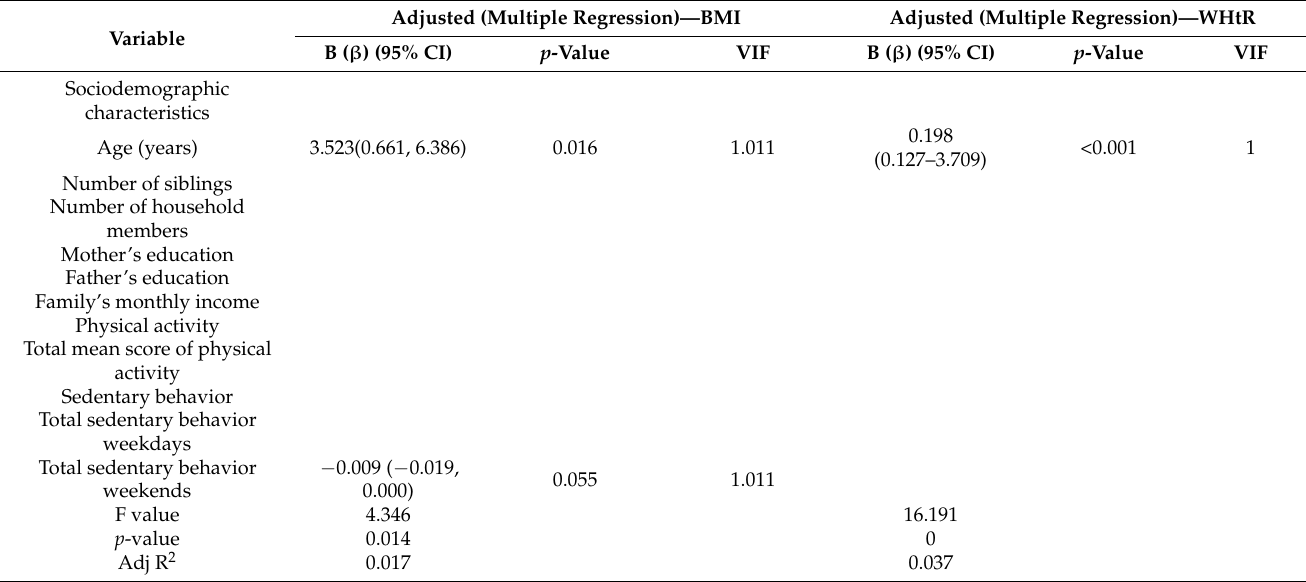
Table 5. Relationship between sociodemographic characteristics, physical activity, and sedentary behavior with BMI and WHtR, explored using simple and multiple regressions